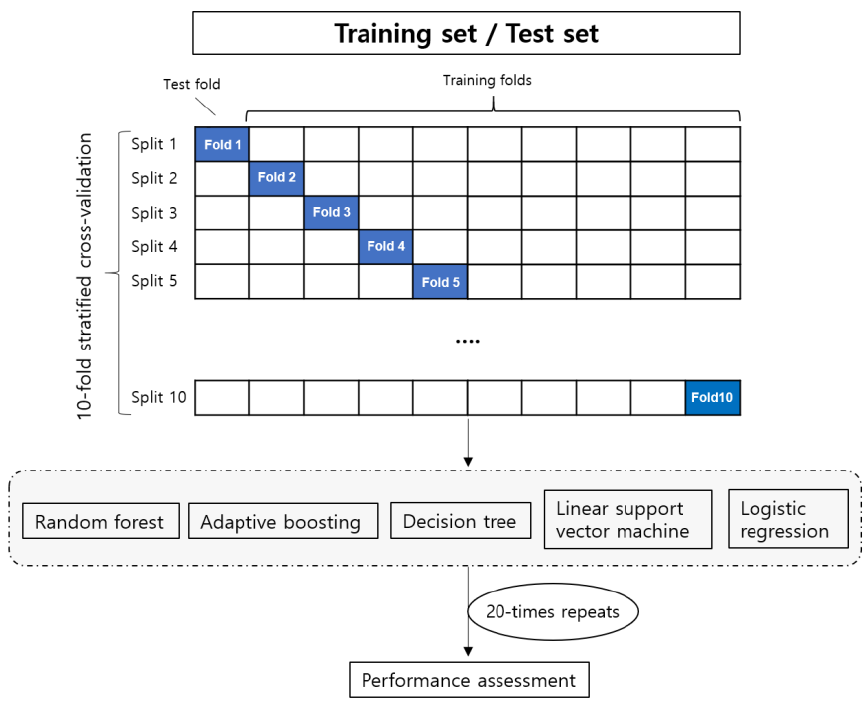
Figure 1. Schematic representation of 20 repeated 10-fold stratified cross-validations on training and test sets.